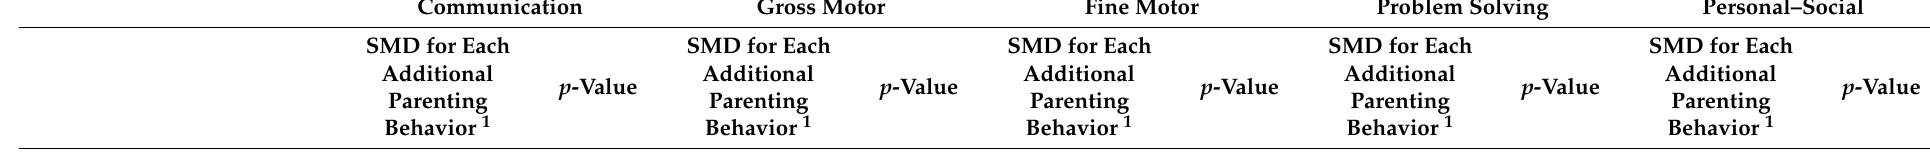
Table 2. Association of the number of positive parenting behaviors with ASQ-3 child developmental domains stratified by child age. Communication Gross Motor Fine Motor Problem Solving